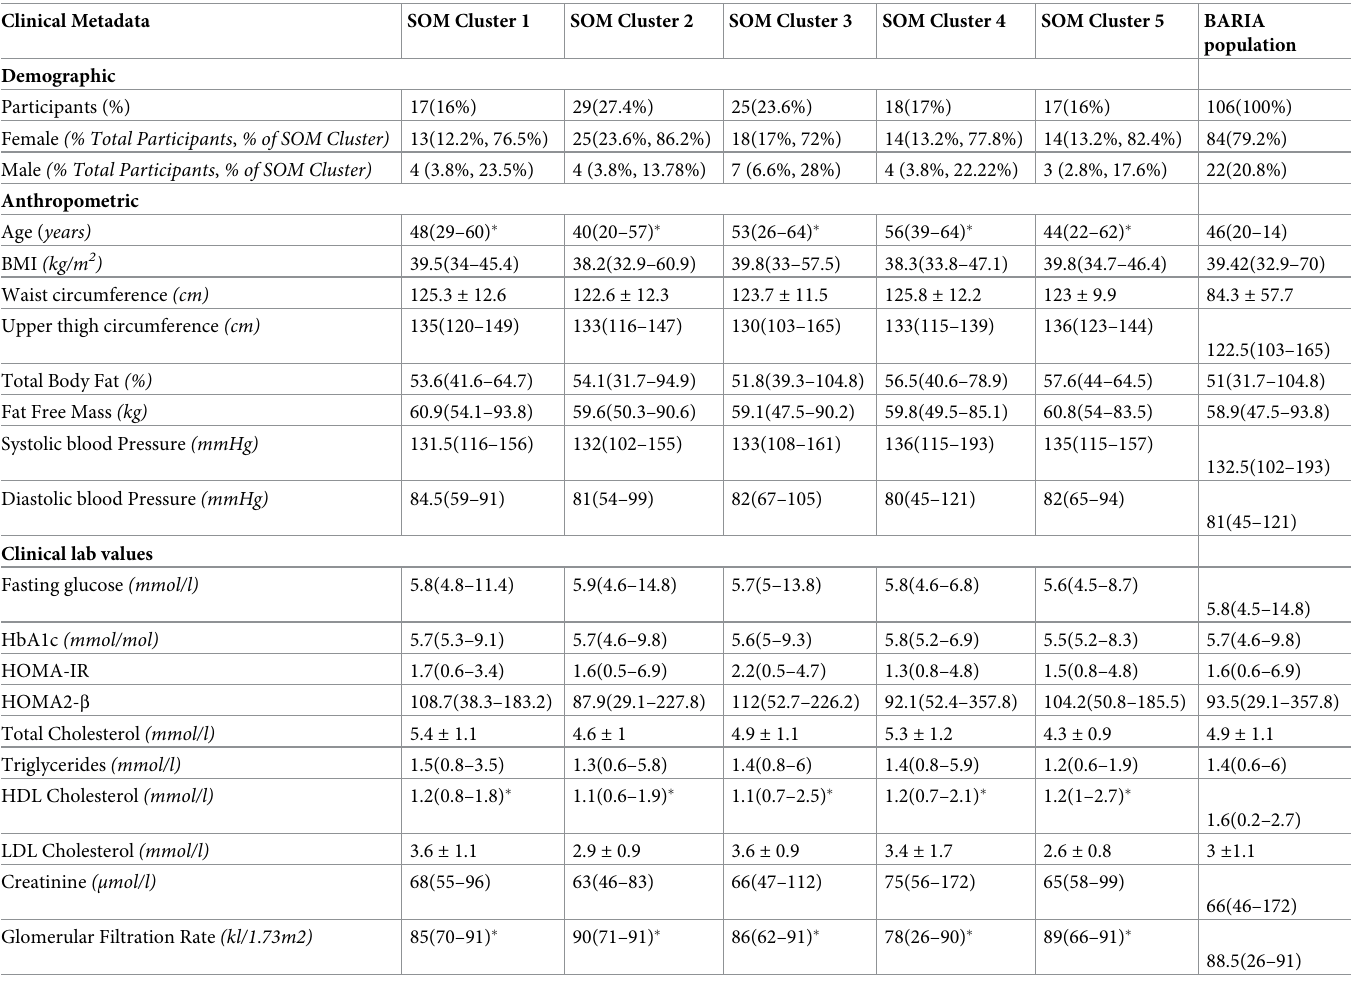
Table 1. BARIA cohort: 106 participants clinical metadata summary for SOM-defined